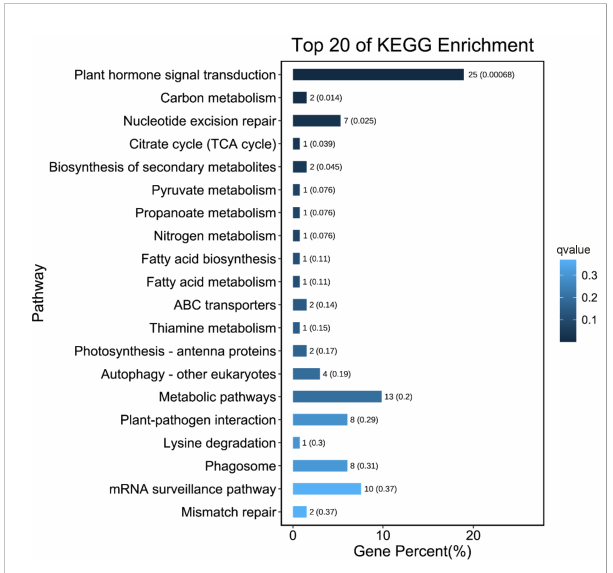
FIGURE 4 Top 20 enriched KEGG pathways for the DEGs between L- and S- morph styles. Smaller Q-value is shown in deeper